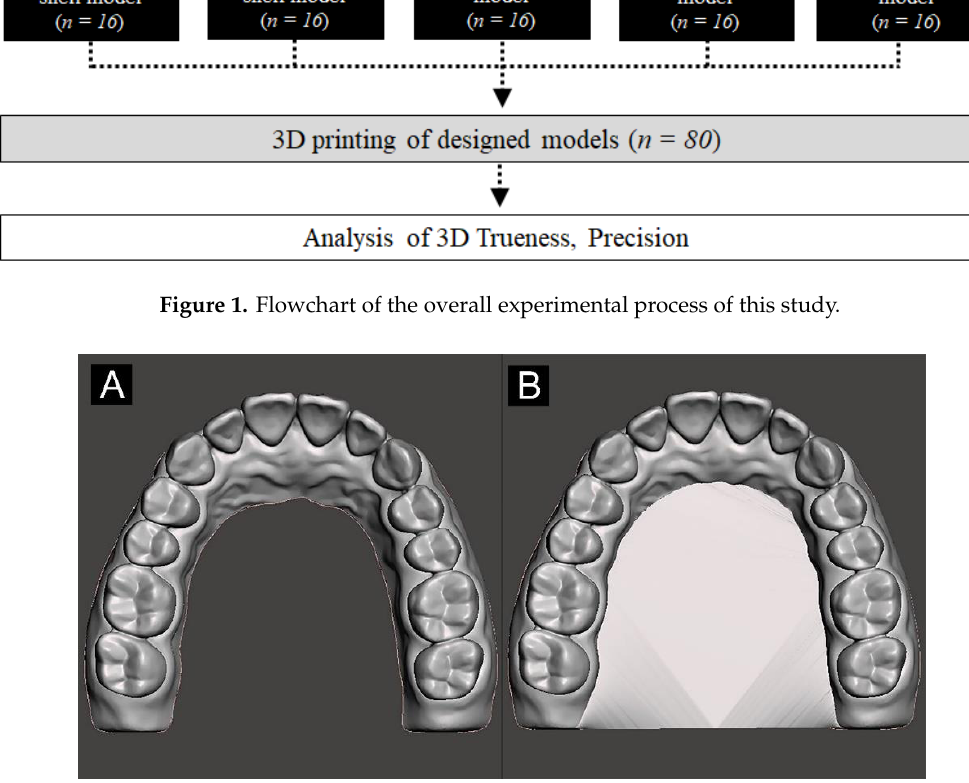
Figure 2. Experimental model designs: ( A ) U-shaped arch and ( B ) cross-arch plate.